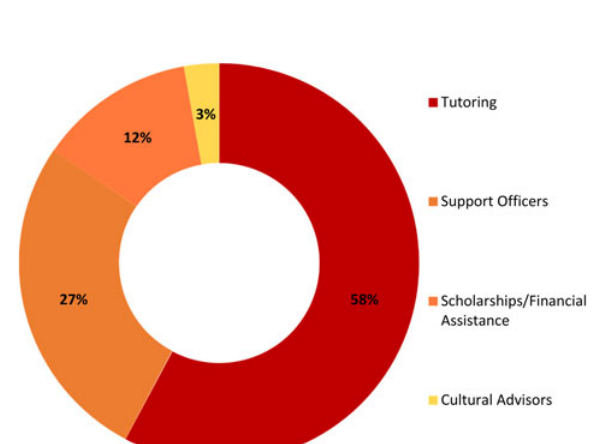
Fig. 6. Visual representation of the reasons students access the Aboriginal Education Unit.